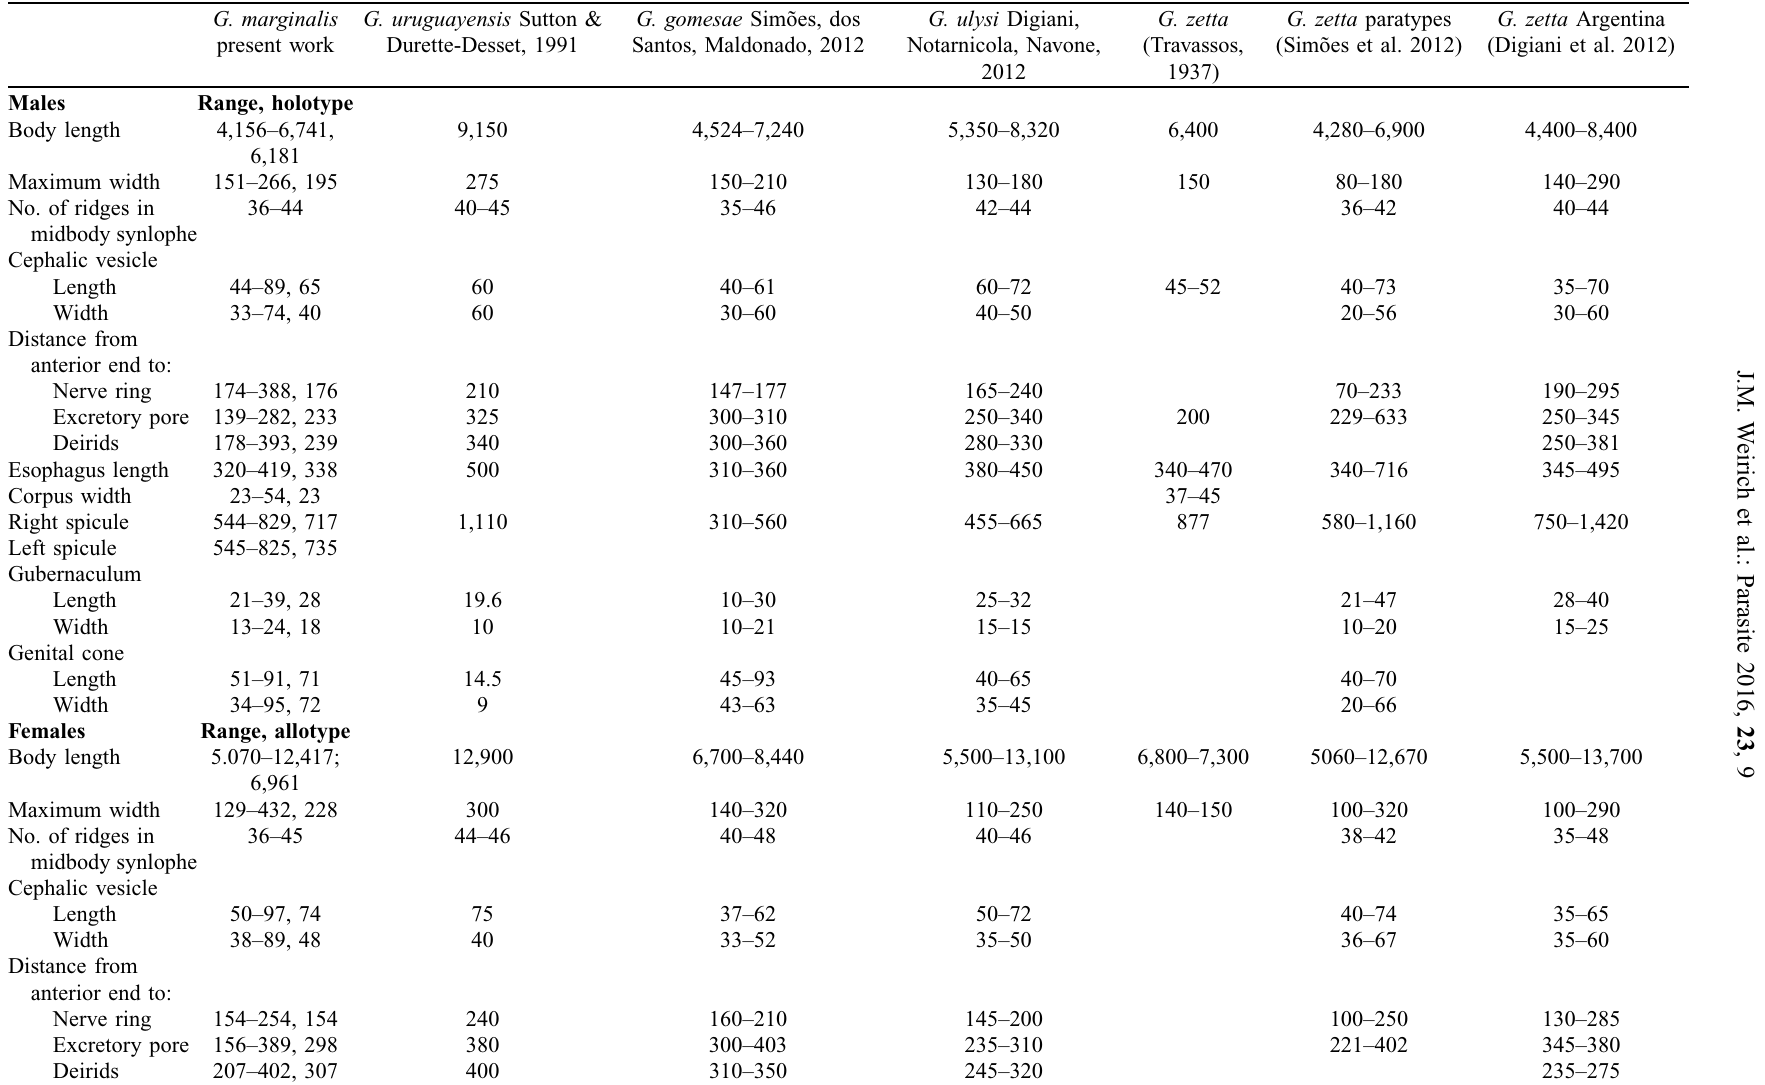
Table 1. Comparative measurements of diagnostic traits for males in Guerrerostrongylus Sutton and Durette-Desset, 1991. For G. marginalis the range is followed by measurements of the type. Values in parentheses include structures measured in three paratypes of G. gomesae . All measurements are in l